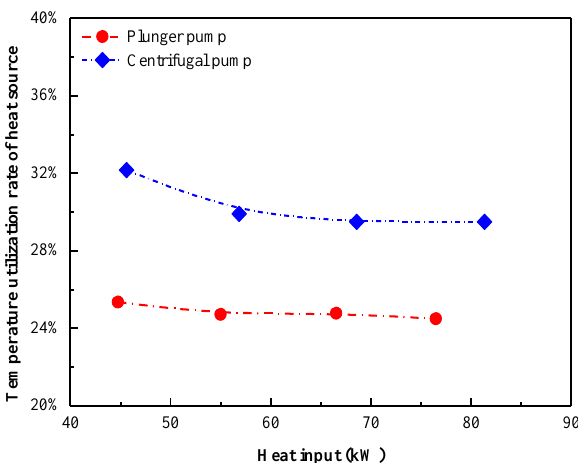
Figure 11. Temperature utilization rate with heat input using the plunger pump and centrifugal pump.